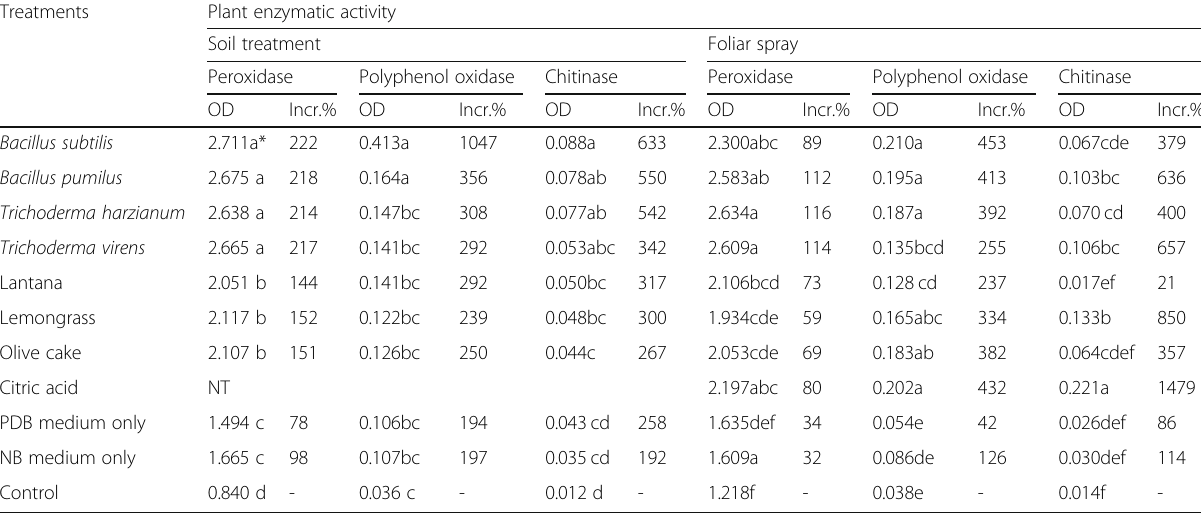
Table 1 Effect of bio-control agents, aqueous plant extracts, and citric acid as soil treatment and/or foliar spray on plant enzyme activity of peroxidase, polyphenol oxidase, and chitinase in field application